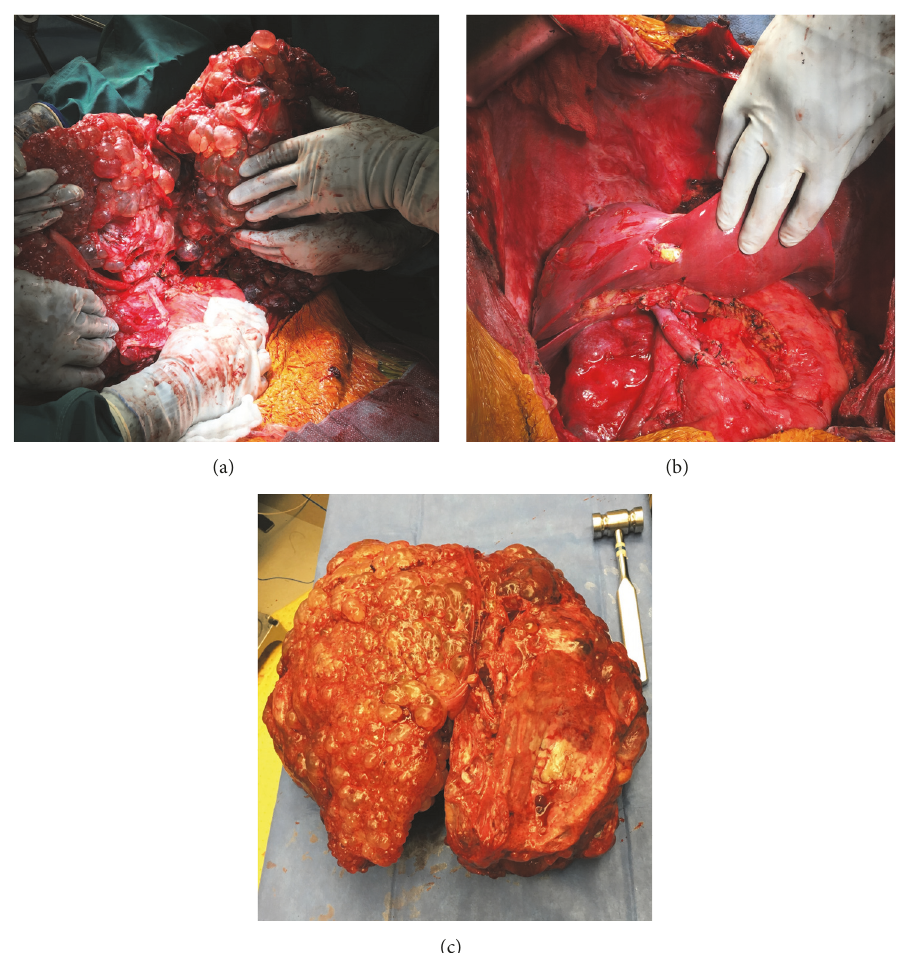
Figure 2: (a) Intraop. imaging of native liver. (b) Liver after reperfusion. (c) Explanted recipient